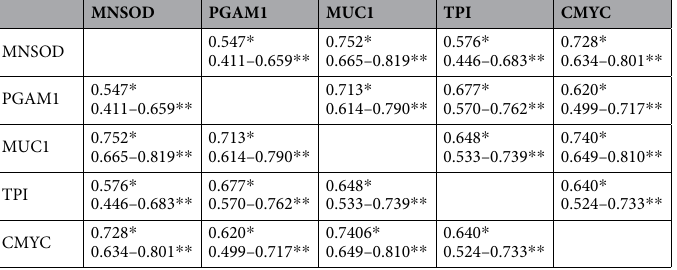
approach of antibody detection to a panel of five TAAs in separating dogs with and without mammary tumours, a group of parameters, such as Youden’s index, positive and negative predictive value ( + PV/ − PV), etc, were cal- culated and summarized in Table 3. The combined biomarker panel showed a positive predictive value of 87.88% and the negative predictive value of 71.19%. Taken together, these data show the usefulness of the multiplex assay in increasing the clinical diagnostic quality and value for mammary cancer diagnosis in dogs.